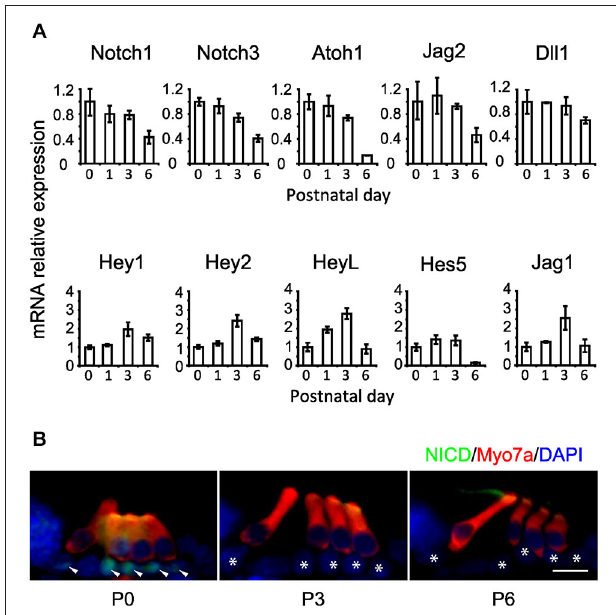
FIGURE 5 | Notch pathway components and Notch1 signaling activity decline during the first postnatal week. (A) Relative expression of some Notch pathway genes obtained by QPCR from whole cochlear explants at 1, 3 and 6 postnatal days relative to newborn (0 postnatal days). N = 3. Error bars: SEM. Note that error bars are present for each condition but are very small in some cases. (B) Notch1 intracellular domain (NICD) immunostaining in cochlear sections of ICR newborn mice, obtained at 0, 3 and 6 postnatal days (P0, P3 and P6 respectively). NICD: green. Myo7a: red. DAPI: blue. Arrow heads: supporting cells positive for NICD staining. Stars: same supporting cells pointed by arrow heads but negative for NICD staining. Scale = 20 µ